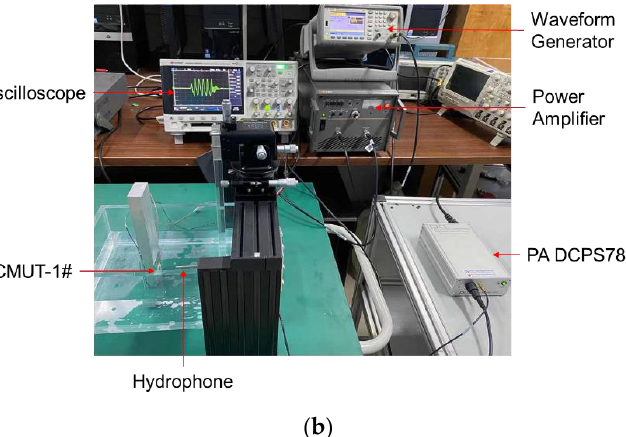
Figure 6. ( a ) Schematic of the measurement setup of the CMUT transmitting performance; ( b ) pho- tograph of the measurement setup.